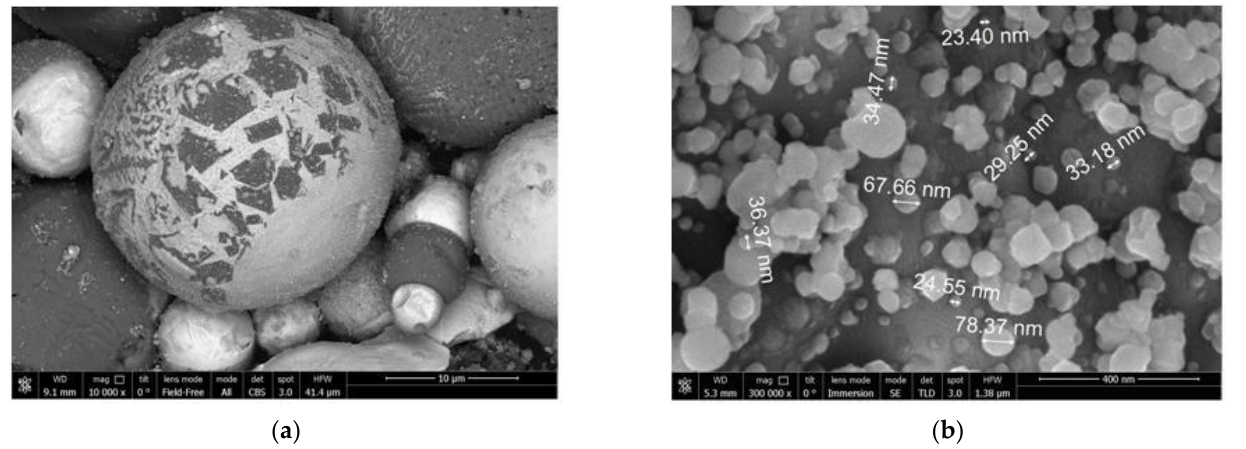
Figure 6. Spherical Al 2 O 3 particles covered with Cu condensate ( a ), 10 µm scale, and Cu nanoparti- cles ( b ), 400 nm